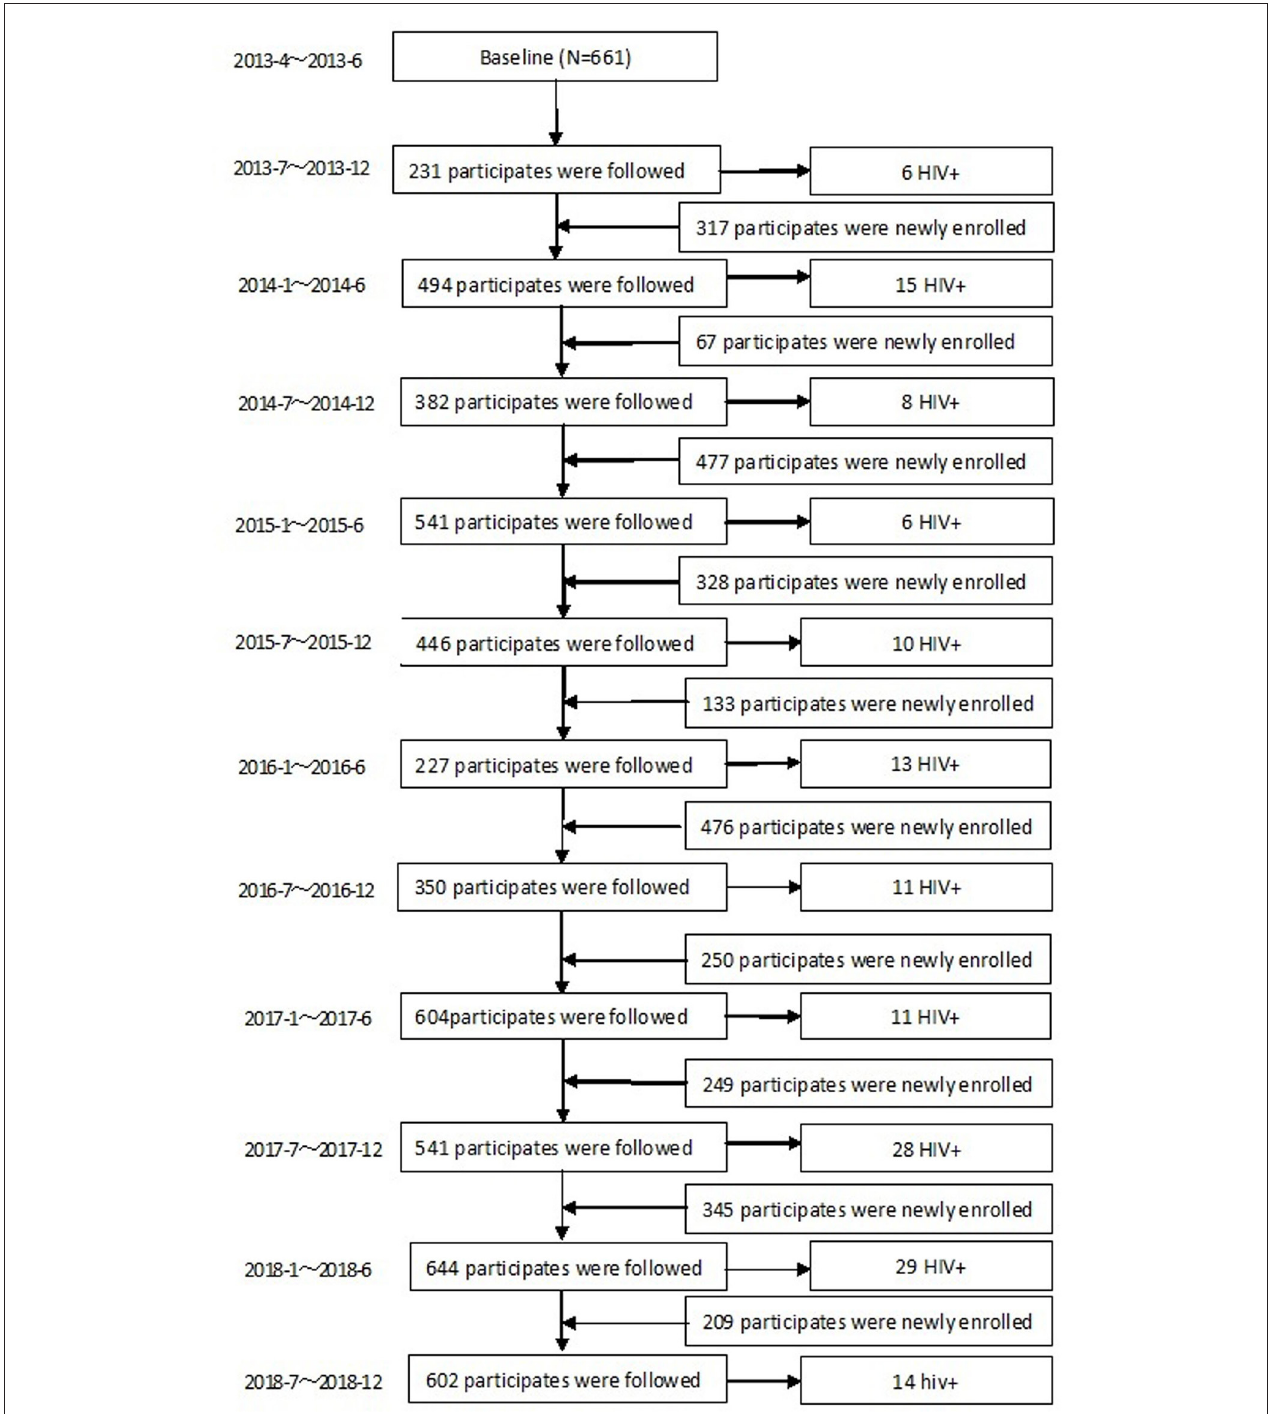
FIGURE 1 | Study flowchart of MSM cohort in